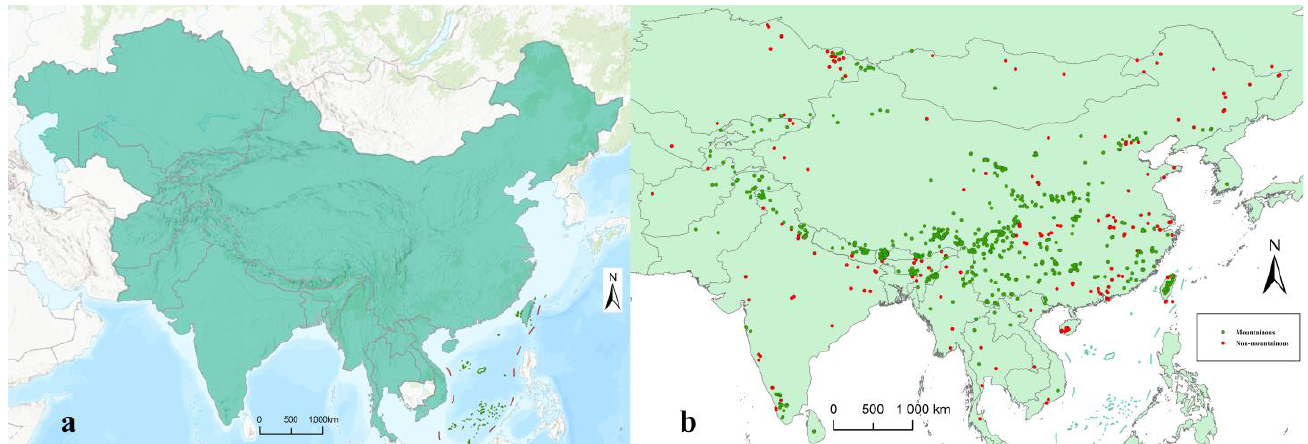
Figure 1. ( a ) Study area (malachite green part). ( b ) Distribution data of Tipulidae in the Qinghai- Tibet Plateau and its surrounding areas (Some data from Mongolia, Sri Lanka, South Korea and Russia were also included, but outside the main study areas). Green and red points represent distribution in mountainous and non-mountainous regions, respectively.